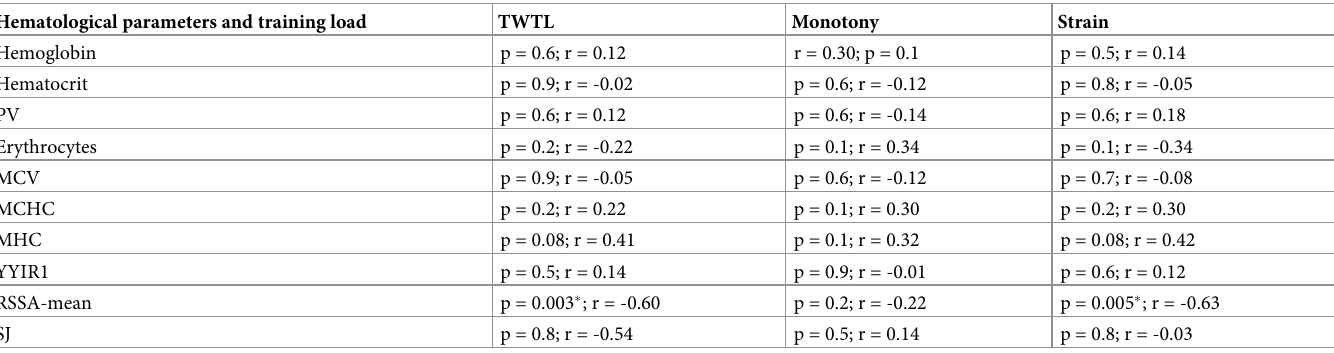
Table 6. Relationships (Pearson correlation coefficient) between PV, percentage changes of hematological parameters, physical fitness, and workload parameters. Hematological parameters and training load TWTL Monotony Strain Hemoglobin p = 0.6; r = 0.12 r = 0.30; p = 0.1 Hematocrit p = 0.9; r =